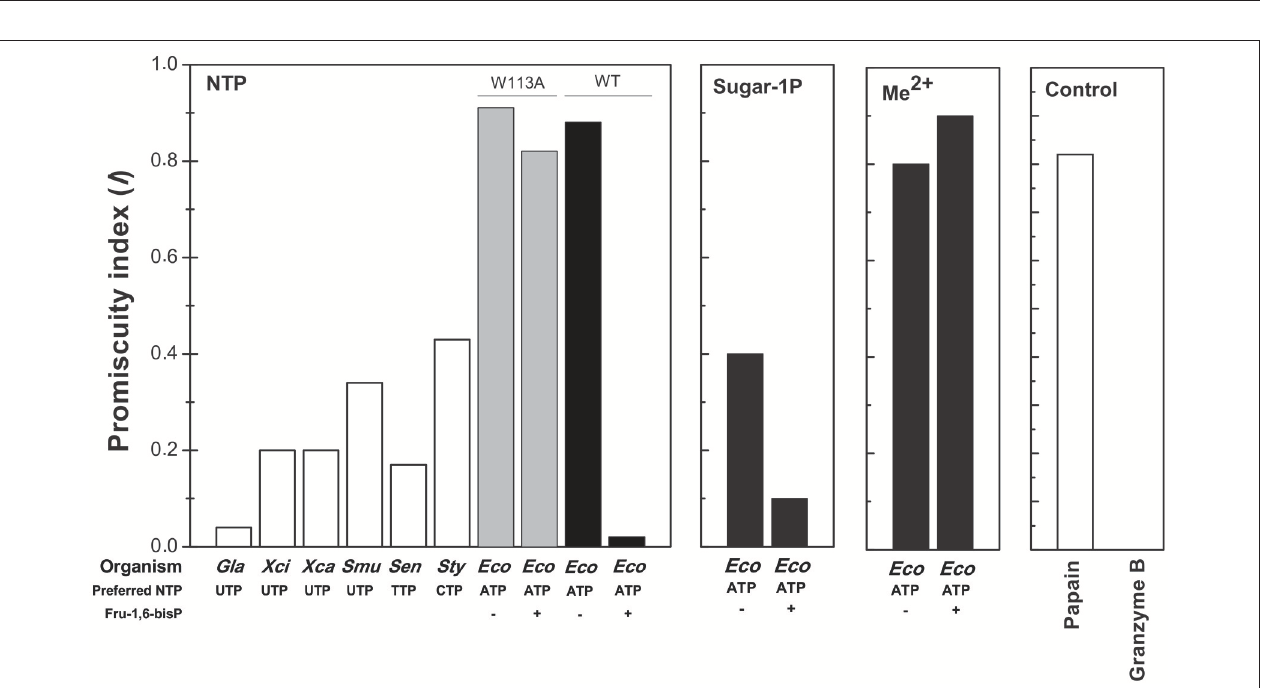
FIGURE 5 | Density volumetric map of NDP-Glc. Top-Volumetric map of ADP-Glc (green) over the last 5 ns of MD overlapped with the density volumetric map of NDP-Glc. Below-average NDP-Glc structures calculated of the last 5 ns of MD overlapped with the average structures of NDP-Glc. The template used to produce the models contains ATP only in subunit A, which is the only one shown here.